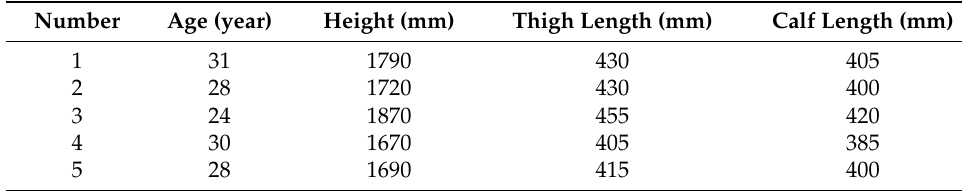
Figure 10. Prototype of the HE-LRR and the control system. Table 1. Basic information of the participants in the